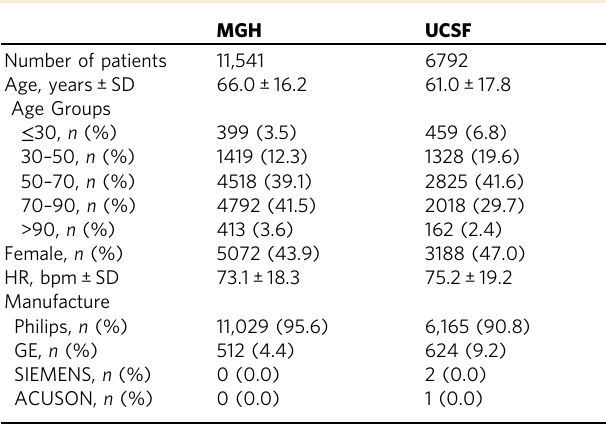
Table 5 Demographic information for deployment simulation